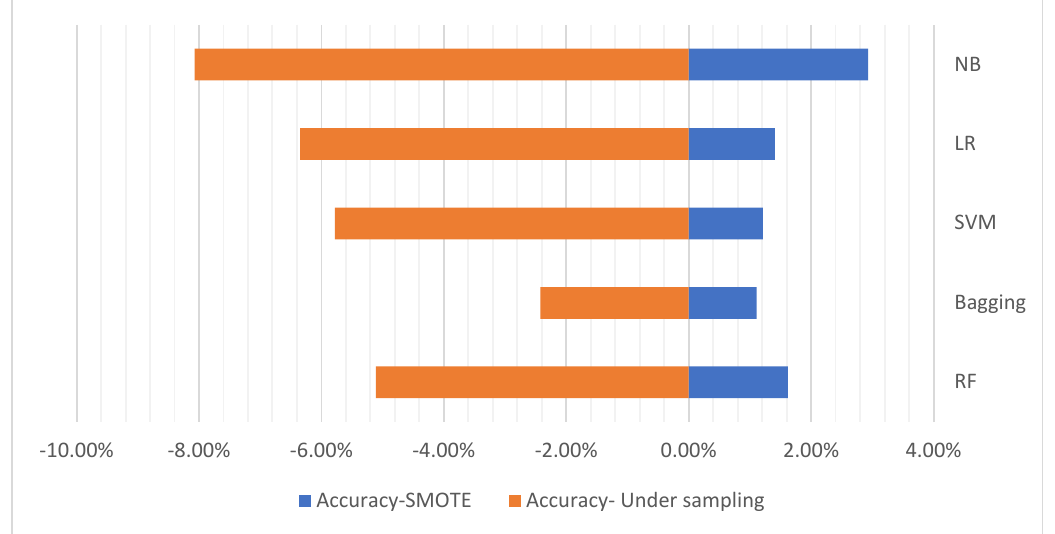
Figure 10. Percentage of change of the ML classifiers with respect to the balancing techniques.